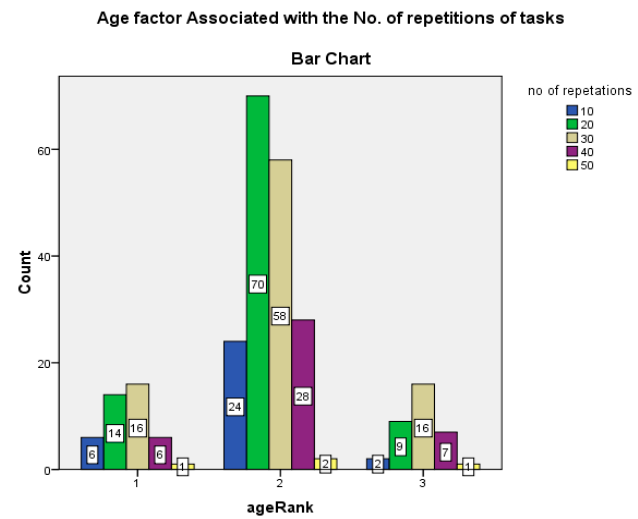
Figure 2. Relation between workers’ age and ability to perform number of repetitions / min.